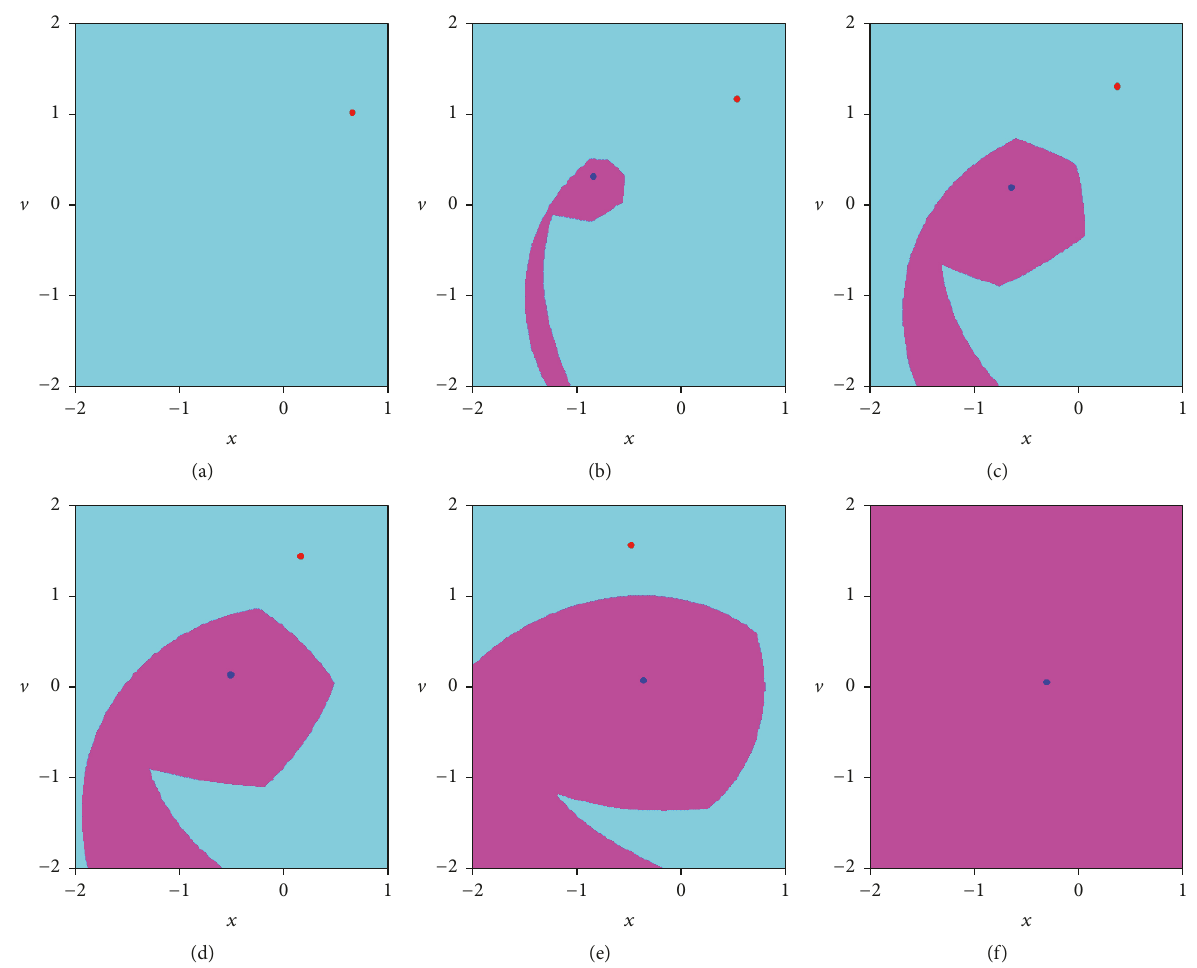
Figure 4: Evolution of the basins of attraction for the impact oscillator with bilinear damping obtained for 𝑎 = 0.3 , 𝑒 = 1 , 𝜉 1 = 0.05 , 𝜉 2 = 0.04 , 𝑟 = 0.7 , (a) 𝜔 = 1.10 , (b) 𝜔 = 1.15 , (c) 𝜔 = 1.20 , (d) 𝜔 = 1.25 , (e) 𝜔 = 1.35 , and (f) 𝜔 = 1.40 . The period-1 orbit with one impact per period is shown in red with a cyan basin, and the nonimpacting period-1 orbit is presented in blue with a magenta